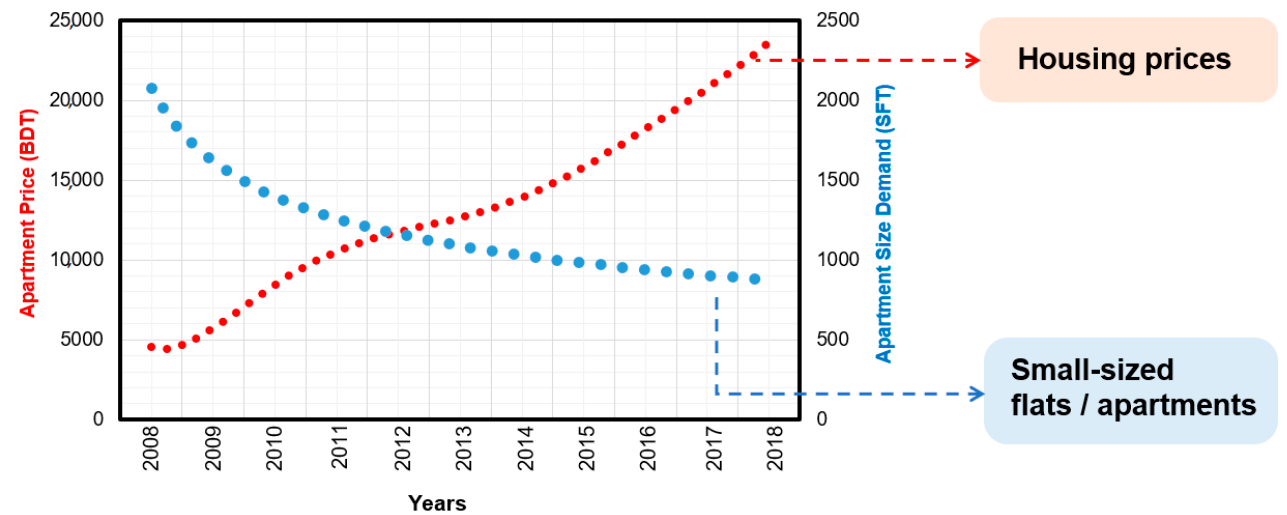
Figure 5. Apartment price vs. apartment size scenario in Dhaka, Bangladesh. Source: [8,9,20,23,29].